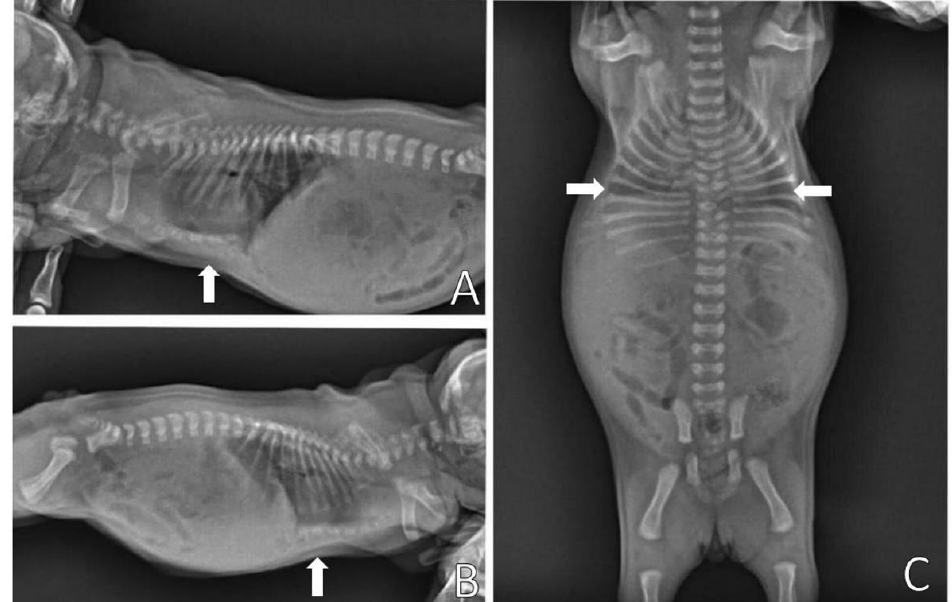
Figure 3. Chest X-ray. ( A ) Right side position and ( B ) left side position, demonstrating ventrodorsal deviation of the sternum bone (arrows); ( C ) Ventrodorsal position demonstrating narrowing of the thorax (arrows), pneumonia and left cardiac deviation.